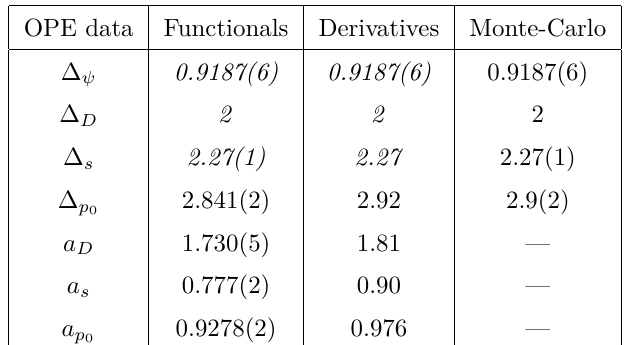
— Table 1 . Numerical estimates of OPE data in the Z 2 twist defect from various approaches. The operators s , p 0 and D are the lowest dimension operatator in the O + , O − , S sectors, respectively S , A and T . The rightmost column shows Monte-Carlo resuts from [24], the middle one is from conformal bootstrap using a derivative expansion [25] and the column on the left is for the present work using GFF analytic functionals. Numbers in italics were used as